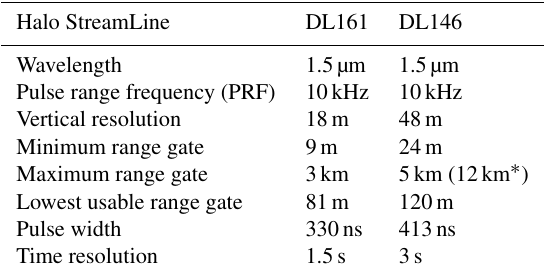
Table 1. Technical specification of Doppler lidars DL161 and DL146.